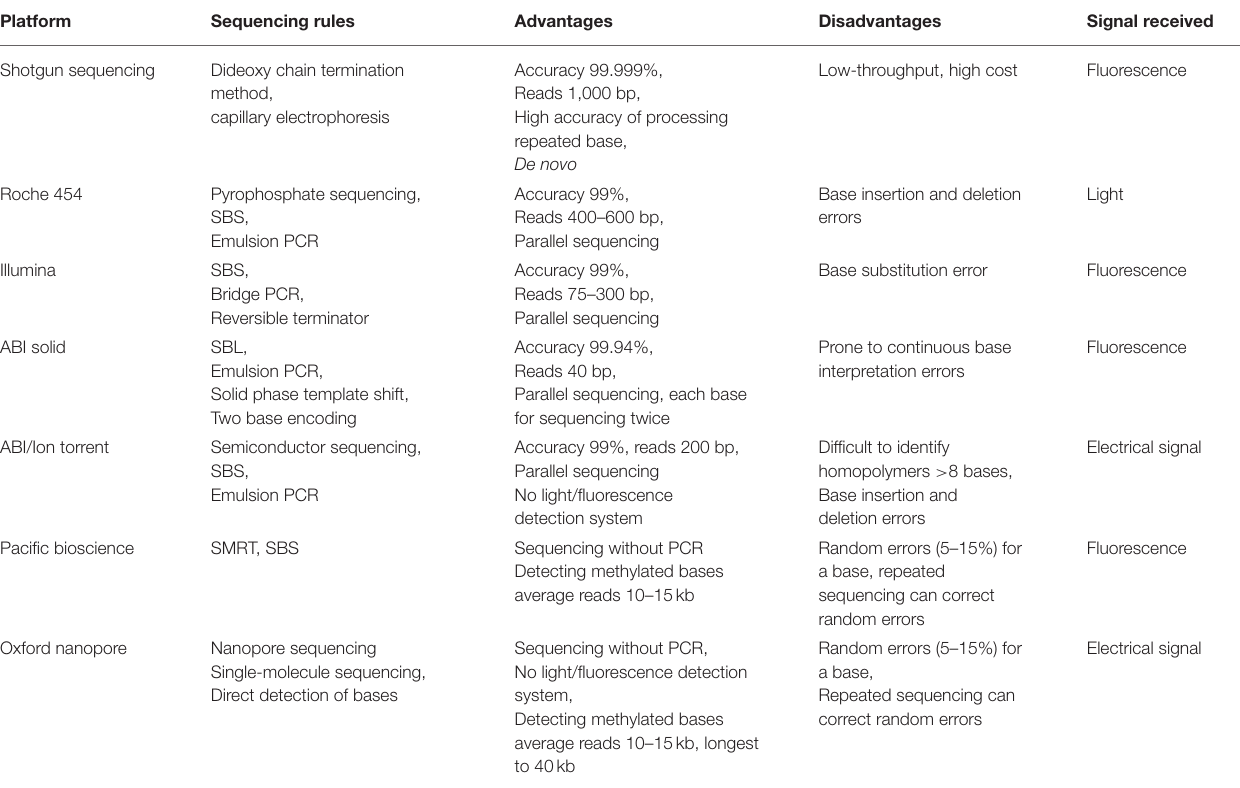
TABLE 1 | Performance COMPARISON of seven sequencing instruments.